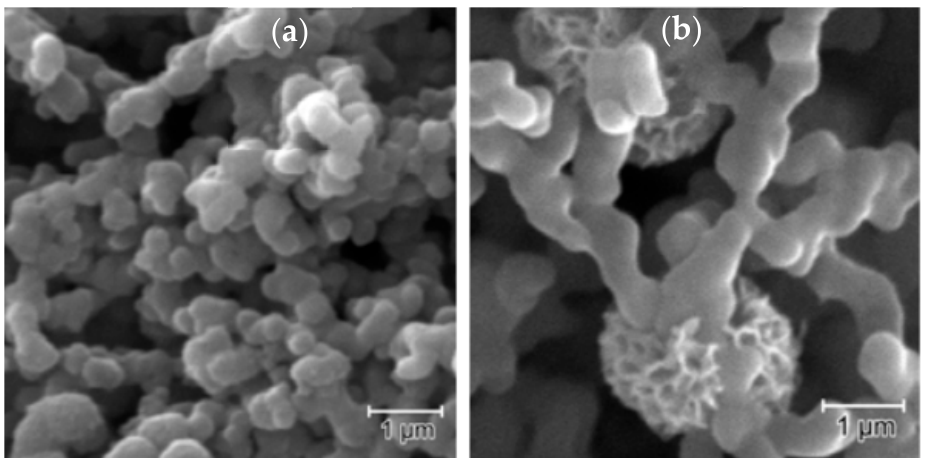
Figure 2. SEM images acquired from ( a ) PANI and ( b ) rGO-PANI. AFM images are displayed in Figure 3. The PANI film had a root mean square roughness (R rms ) of 75 nm, resulting from the chain aggregates [44,48]. The surface of rGO-PANI film presented R rms of 20 nm, while the corresponding force mode image showed regions with different contrasts, arising from regions with different mechanical features related to the PANI and rGO-rich PANI surfaces, illustrating the distribution of rGO along the PANI surface.